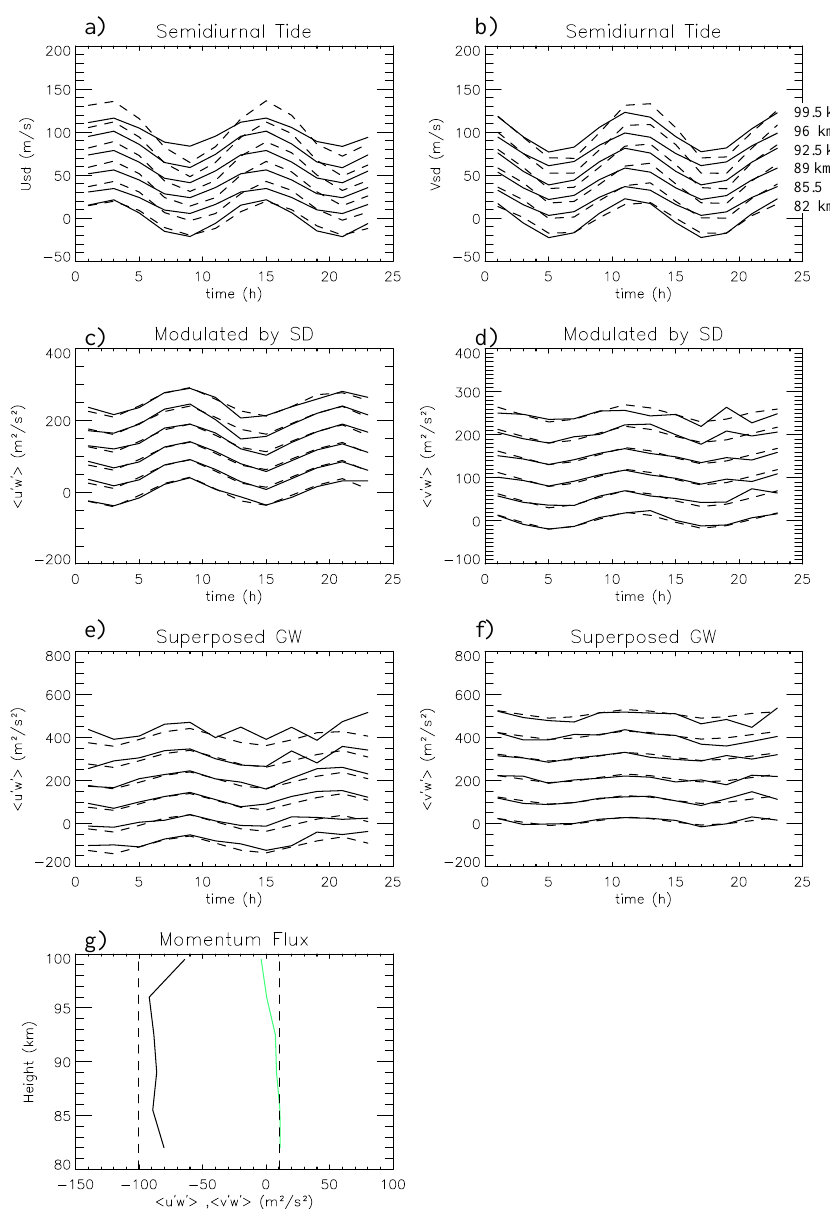
Fig. 14. (a) and (b) composite day hourly semidiurnal tides for Case 3. (c) and (d) zonal and meridional composite day hourly GW momentum fluxes for the GWs modulated by the semidiurnal tide. (e) and (f) zonal and meridional composite day hourly GW momentum fluxes for the superposition of zonal and meridional stationary GWs and the GWs modulated by the semidiurnal tide. Specified and recovered fields are shown with dashed and solid lines, respectively; offsets plotted between successive 3km altitudes are 20ms − 1 for the semidiurnal tide and 50m 2 s − 2 for the GW momentum fluxes. Altitudes range from 82 to 99.5 in each panel. Small meteor detection rates limited measurement accuracies at the highest and lowest altitudes.